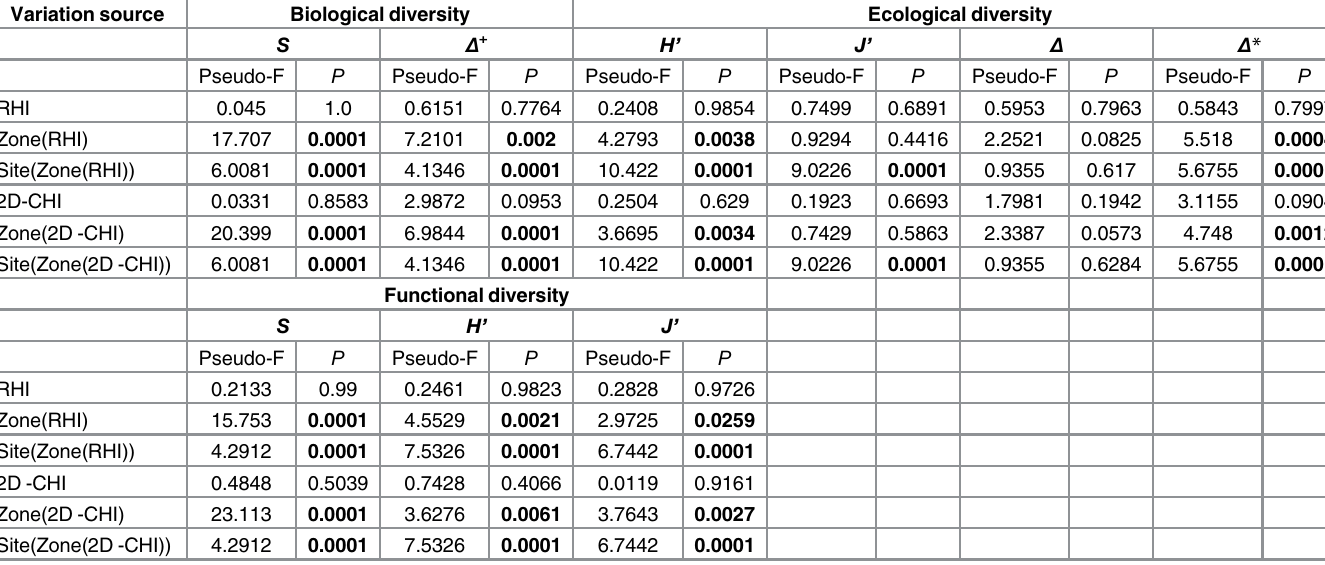
Table 4. Three-way fully nested and permutational ANOVAs outcomes contrasting the biological, ecological and functional diversity of herma- typic corals among different health grades of RHI and 2D-CHI indices, among zones nested in health grades and among sites nested in zones and health